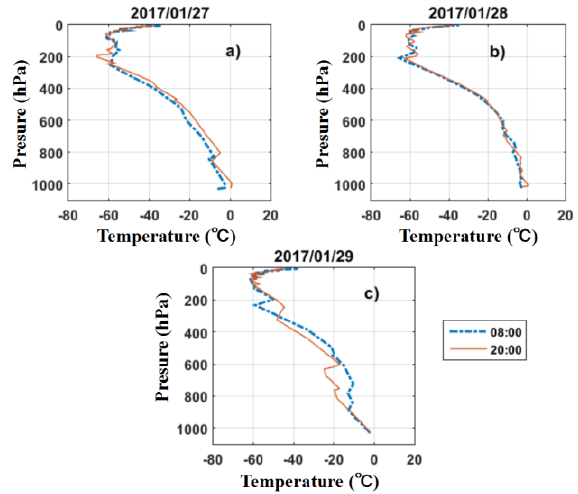
Figure 5. Profiles of temperature from radiosonde observations at a Beijing site, which is 135 km away from Baoding on January 27, 28 and